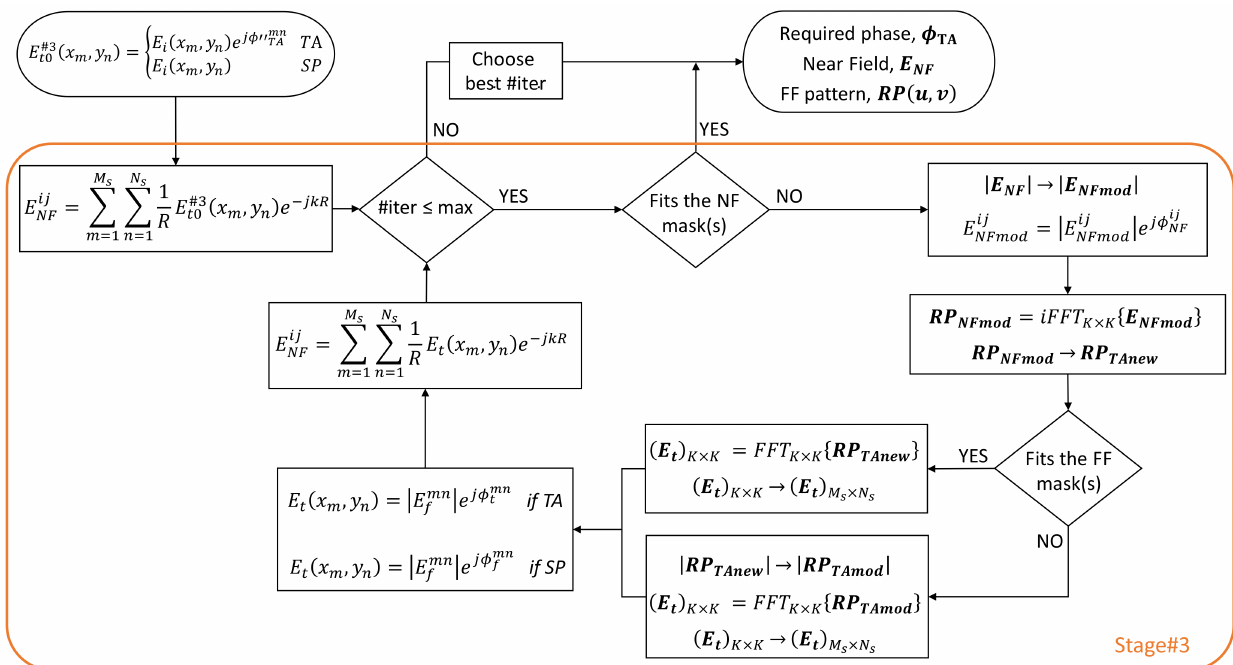
Figure 3. Flowchart of Stage#3: NF–FF